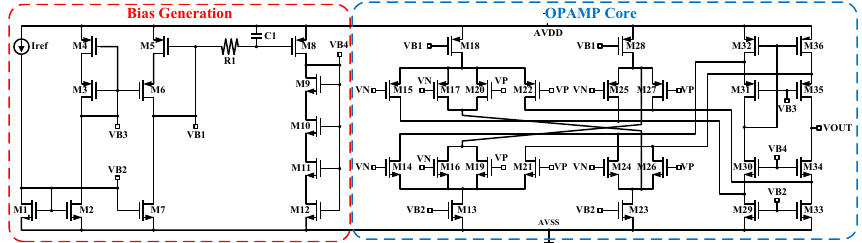
Figure 4. Rail-to-rail OPAMP schematic.